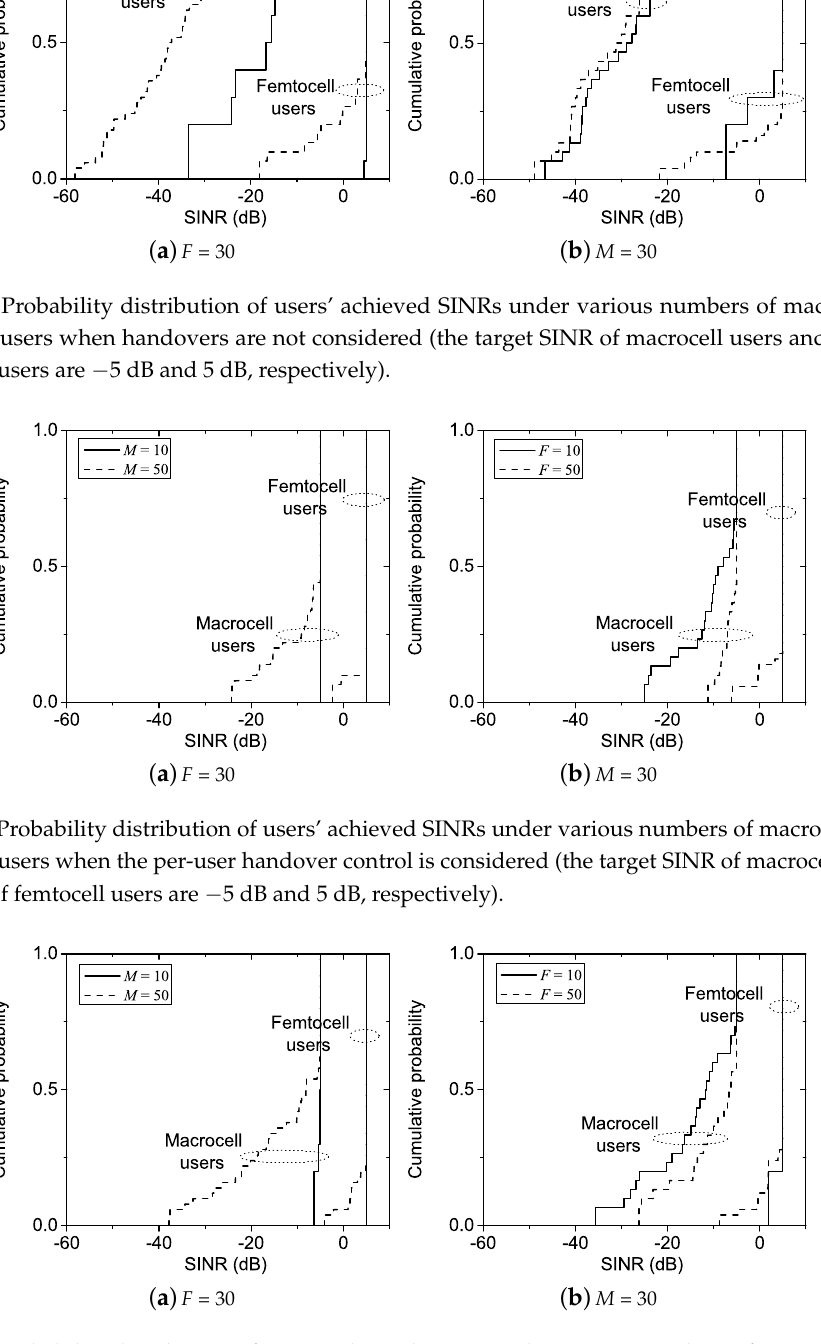
Figure 8. Probability distribution of users’ achieved SINRs under various numbers of macrocell and femtocell users when the range control is considered (the target SINR of macrocell users and that of femtocell users are − 5 dB and 5 dB,